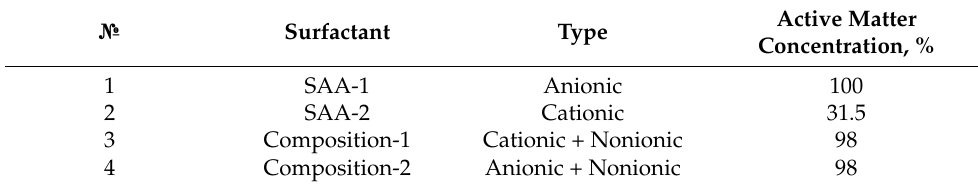
Table 3. Surfactants’ properties.